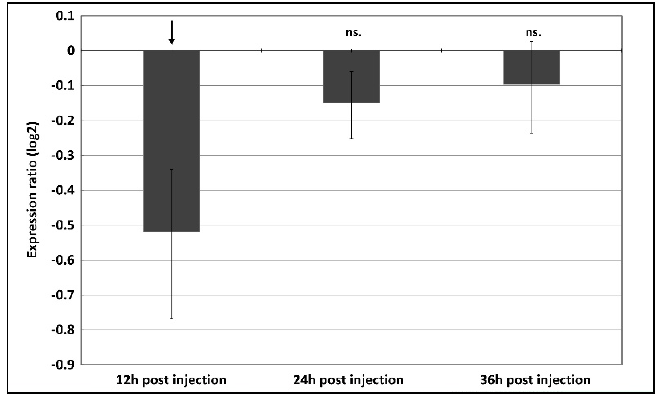
Figure 2. Expression ratio (log2) of p300 mRNA transcript determined using qPCR at 12 h, 24 h and 36 h post injection of gene-specific dsRNA in relation to the transcript expression in a GFP dsRNA treated control group. A negative expression ratio indicates downregulation, the expression was normalized against reference gene rpl32 . Arrow indicates a significant variation of gene expression as calculated by REST analysis ( p = 0.015). ns—not significant.